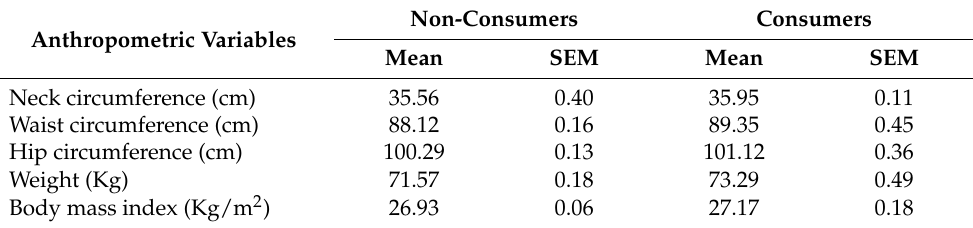
Table 2. Anthropometric variables between consumers and non-consumers of alcohol. Anthropometric